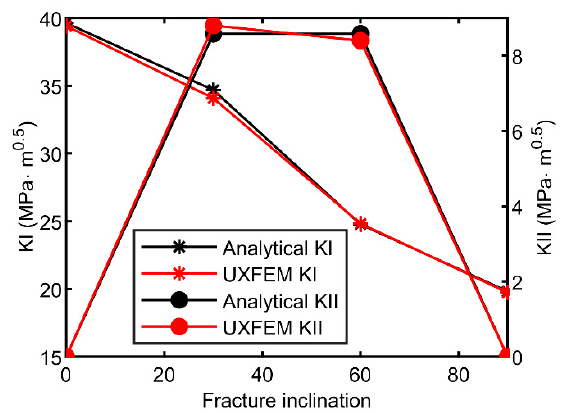
Figure 6. Calculation results comparison of stress intensity factor between UXFEM and analytical solution.